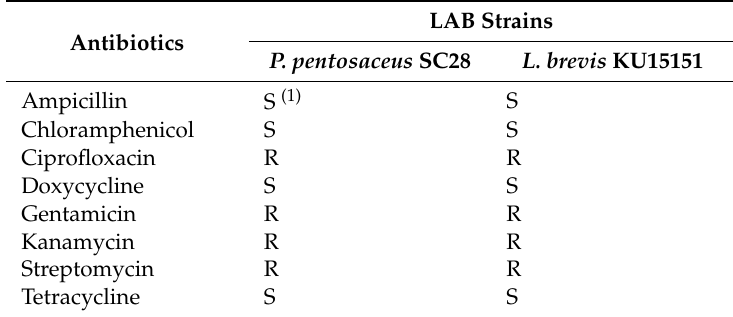
Table 3. Antibiotic susceptibility of LAB